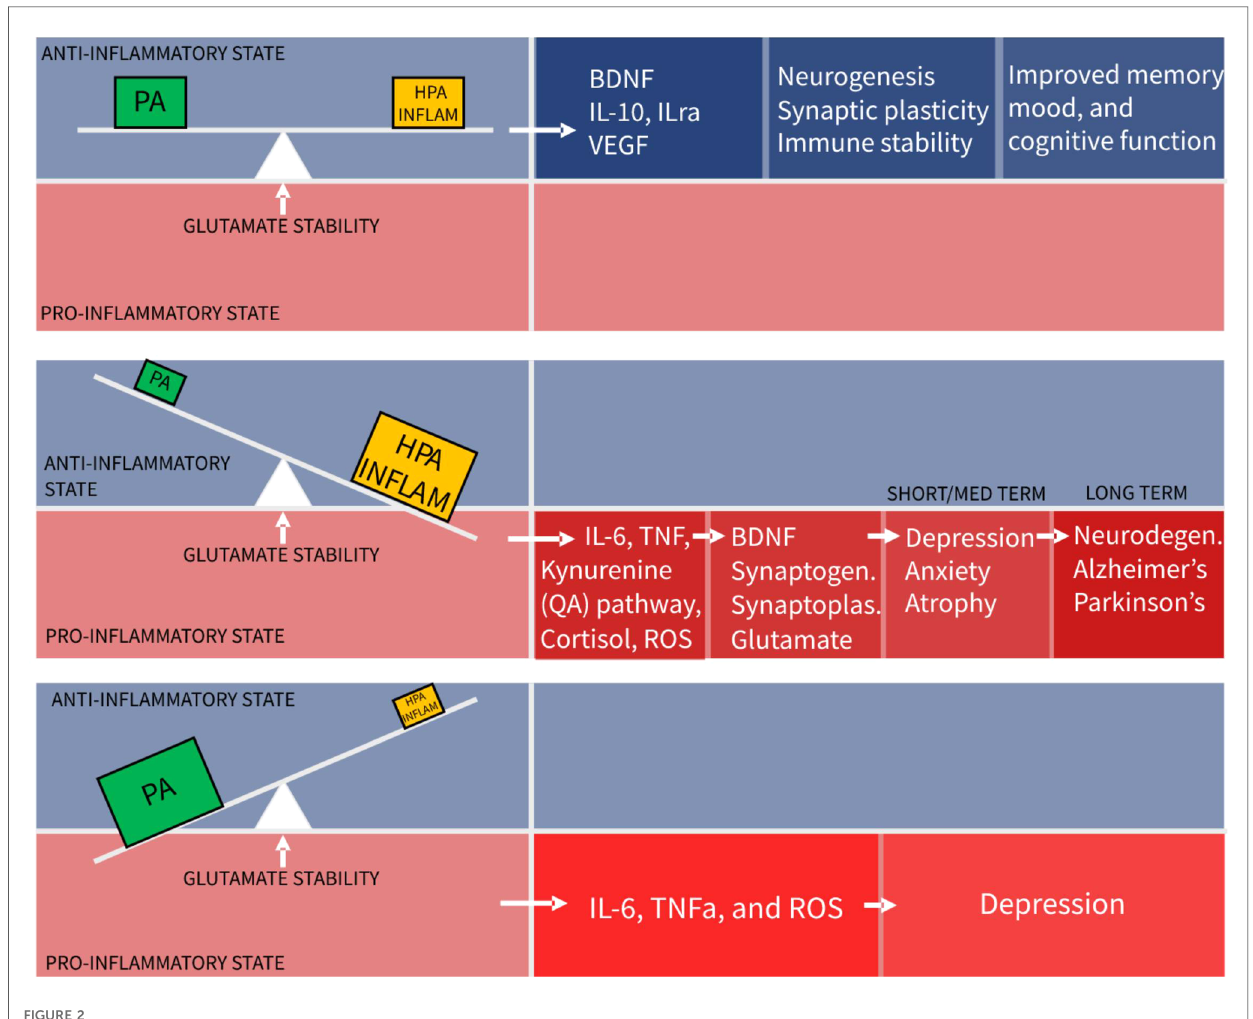
FIGURE 2 The seesaw principle of glutamatergic homeostasis (PA, physical activity; HPA, hypothalamo-pituitary-adrenal